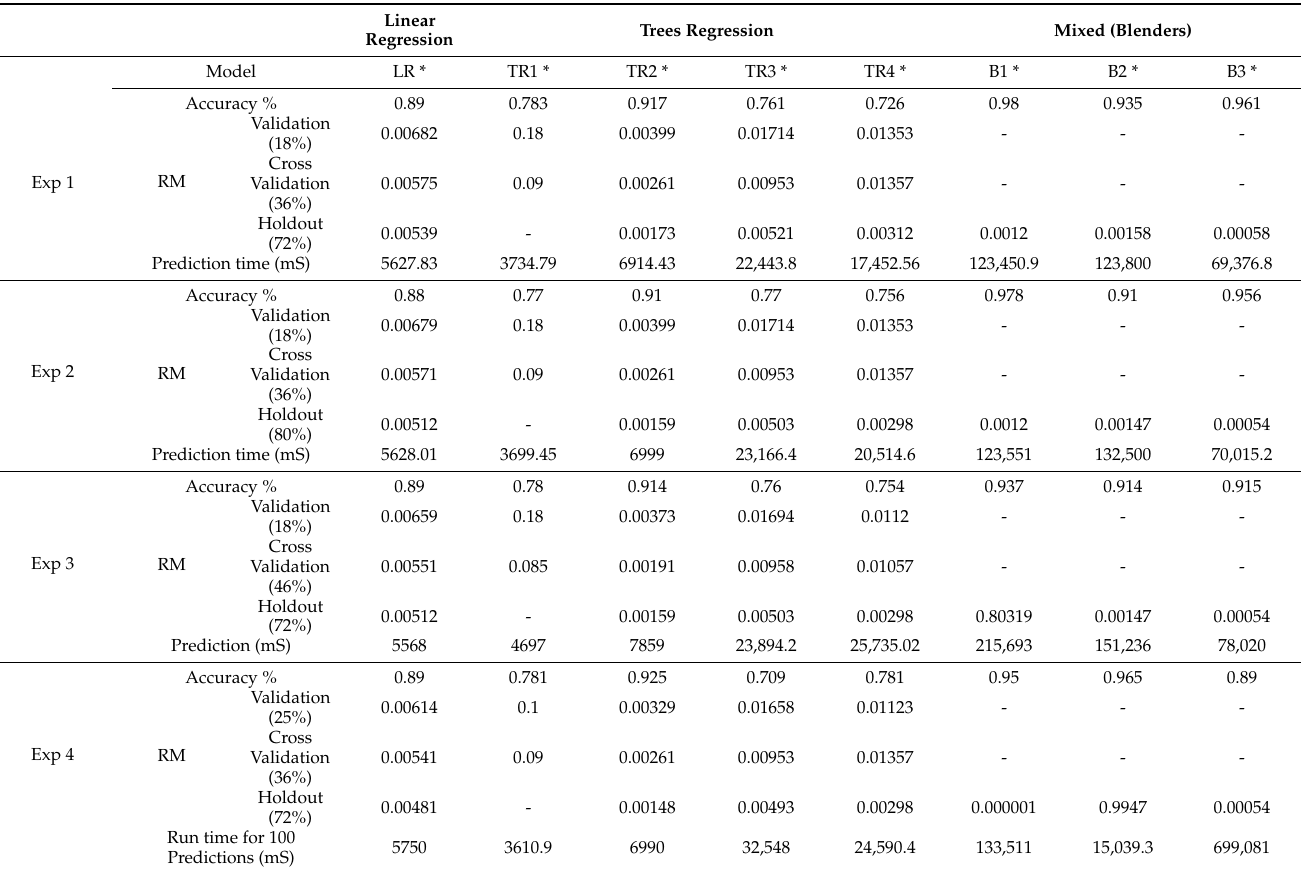
Table 3. Performance comparison summary between RM values, accuracy, and prediction time